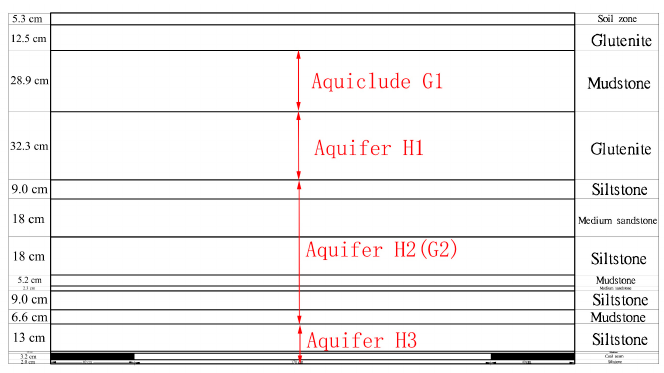
Figure 4. Illustration of the design of the present similar materials model test.